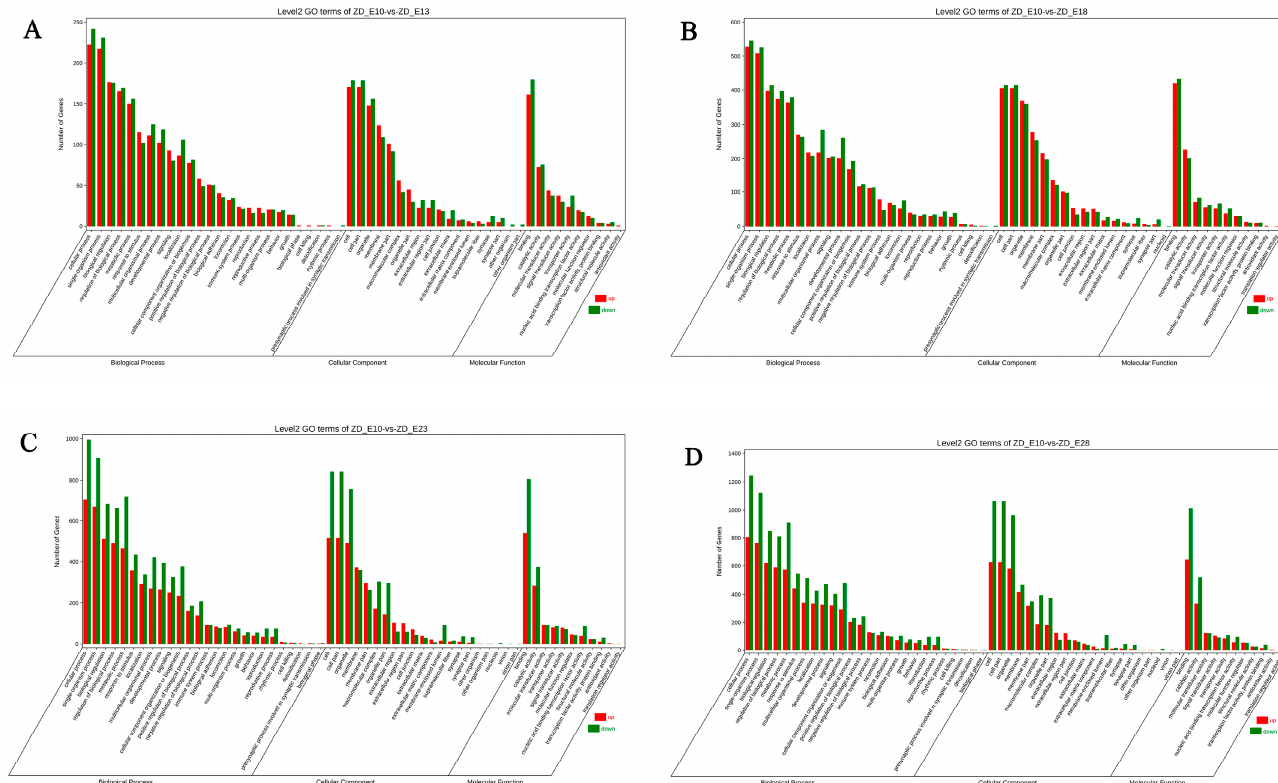
Figure 3. GO analysis of genetic differences in skin and feather follicle development in Zhedong white geese. ( A – D ) shows the comparison group of E13, E18, E23, and E28 with E10. The results are summarized into three major groups: Biological process, cellular component, and molecular function. The Y -axis displays the percentage of genes, while the X -axis represents the second level term of the gene ontology.